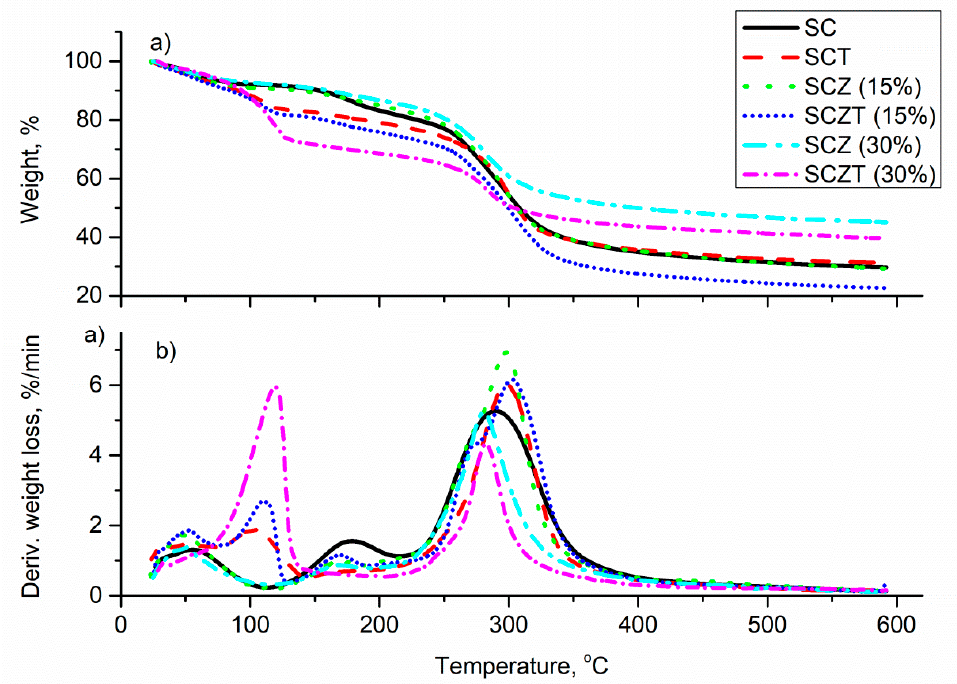
Figure 4. ( a ) TGA and ( b ) DTG curves of the prepared films.